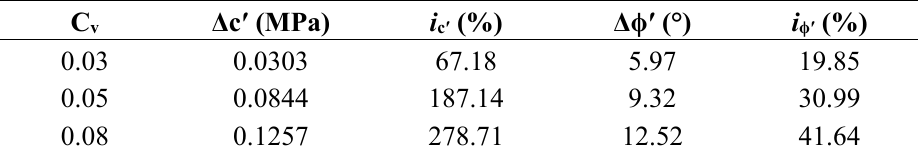
Table 5. The change of c ′ and ϕ ′ with different C v